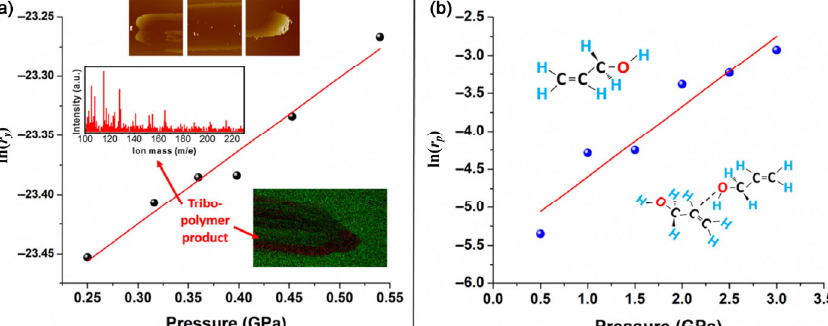
Fig. 15 (a) Rate of measured normalised tribo-polymer yield versus applied contact pressure. Insets are AFM images of a rubbed track, a mass spectrum of tribo-products from ToF-SIMS analysis, and a ToF-SIMS imaging ion map. (b) Rate of tribo-polymer formation predicted from MD simulations. Insets show the structures of an allyl alcohol molecule and an intermediate dimer. Reproduced with permission from [131]. Copyright ACS,